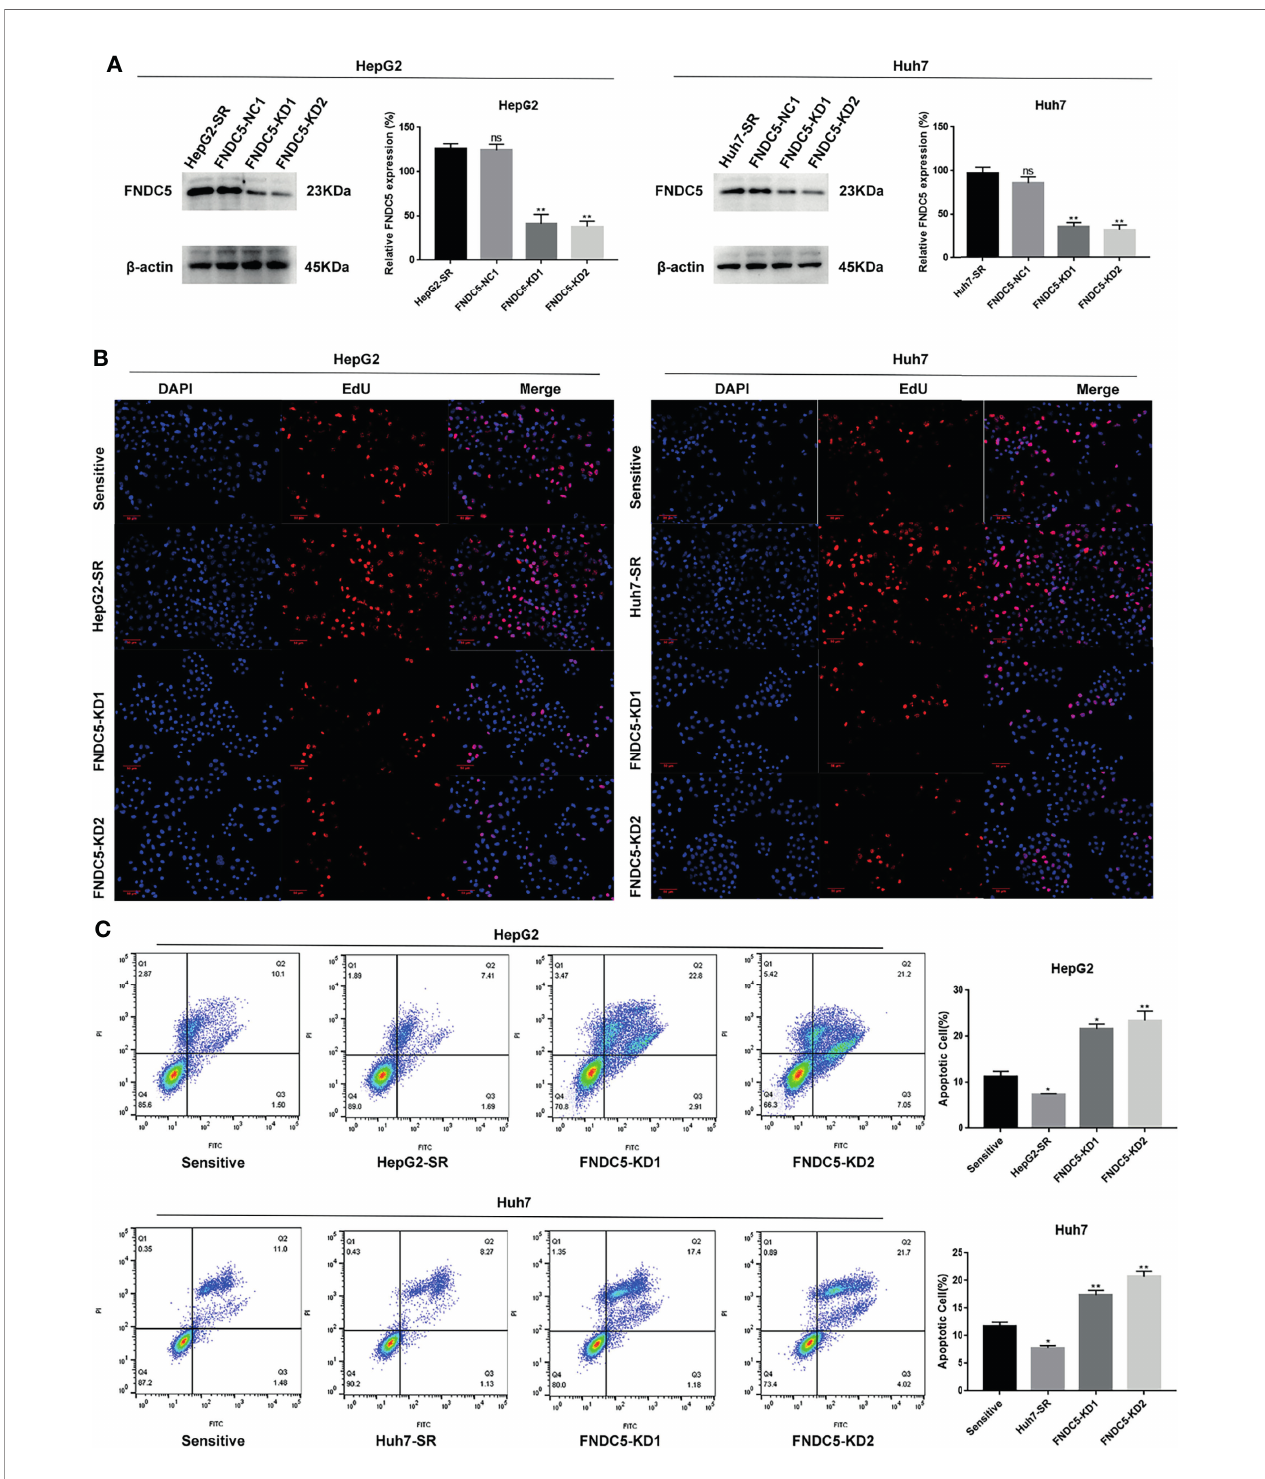
FIGURE 2 | Knockdown of FNDC5 decreases drug resistance in sorafenib-resistant HCC cells. (A) A lentiviral plasmid vector was used to knockdown FNDC5 in drug-resistant cell lines; the knockdown effect was veri fi ed using western blotting. *Compared with the drug-resistant cell lines, *p < 0.05, **p < 0.01. Sorafenib (10 µM) was administered to sorafenib-sensitive HCC, drug-resistant, and FNDC5-knockdown drug-resistant cell lines for 24 h. (B) EdU staining was used to detect viability in each group of cells. (C) Annexin-V-FITC/PI staining was used to determine the inhibitory ability of sorafenib in each group of cells. *Compared with the sorafenib-sensitive HCC cells, *p < 0.05, **p < 0.01. ns, no signi fi cant